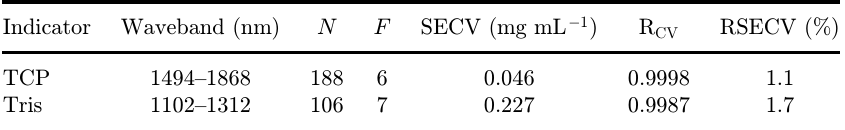
Table 4. Parameter selection and prediction e®ects of the optimal AO – MW – PLS models for TCP and Tris.